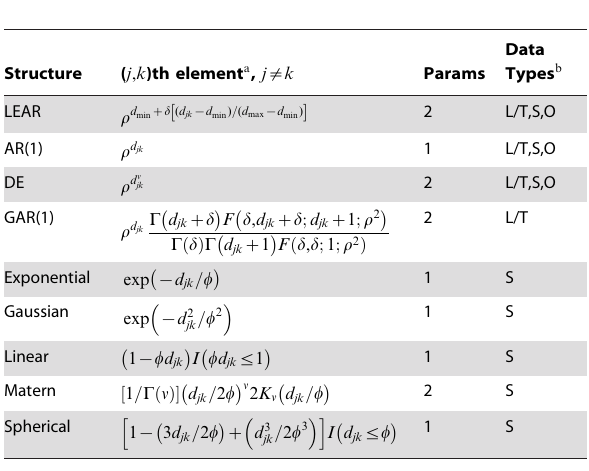
Table 1. Stationary Correlations Structures That are Continuous Functions of Distance.